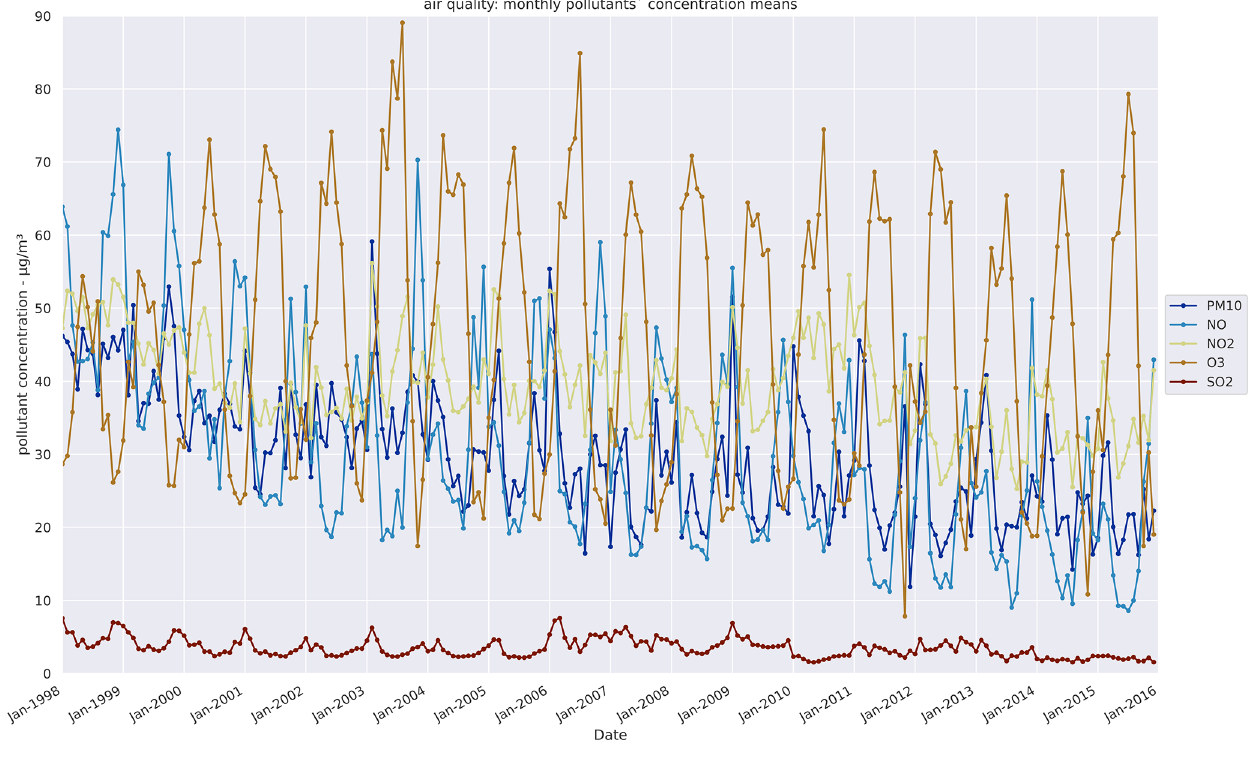
Figure A9. Monthly mean time series for all air quality features.